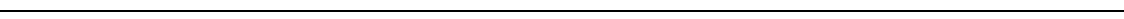
Fig. 8 Flippase activity of ATP11C inhibited by PKC is partially rescued by endocytosis-defective mutants. a – d Ba/F3 cells stably expressing the indicated point mutants of ATP11C-HA were treated with vehicle alone (Mock), 400 nM PMA (PMA), or 1 μ M A23187 in the presence of CaCl 2 (A23187) for 15 min. a Cells were immunostained with anti-HA and anti-ATP1A1 antibodies, followed by incubation with Cy3-conjugated anti-rat and Alexa Fluor 488- conjugated anti-rabbit secondary antibodies. Scale bars, 20 μ m. b The cells with ATP11C mutants localized to the plasma membrane (PM), to the plasma membrane and endosomes (PM + E), or to the endosomes (E) were counted; counts were normalized against the total number of counted cells. In each sample, 315 – 459 cells were counted. Graphs display averages ± SD from three independent experiments. c Cell-surface expression level of ATP11A, ATP11C, and the indicated mutants upon treatment with PMA were analyzed after surface biotinylation. Proteins precipitated with streptavidin-agarose beads were subjected to immunoblot analysis (upper panels, biotinylated). Ten percent of the input of the biotinylation reaction was loaded in each lane (lower panels, total lysate). Expression levels of P4-ATPases were analyzed by immunoblotting with anti-HA and anti-ATP1A1 (as an internal control) antibodies. d Relative surface expression levels of proteins, normalized against the level of ATP1A1 (used as an internal control). Graphs display averages ± SD from four independent experiments. ** p < 0.005; *** p < 0.001. e , g Ba/F3 cells stably expressing ATP11A, ATP11C, the indicated point mutant of ATP11C, or ATP11C(9-Ala) were treated with vehicle alone (white bars) or 400 nM PMA (black bars) for 15 min. The cells were then washed with fl ippase assay buffer and incubated with NBD-PS at 15 °C for 5 min. After extraction with fatty acid-free BSA, the residual fl uorescence intensity associated with the cells was determined by fl ow cytometry. Fold increase in NBD-PS uptake is shown relative to that in parental Ba/F3 cells ( − ). Graphs display averages ± SD from four ( e ) or three ( g ) independent experiments. f , h Ratio of PS- fl ip activity in PMA vs. mock-treated cells in e and g , respectively. Graphs display averages ± SD from four f or three h independent experiments. * p < 0.01; ** p < 0.005; *** p <